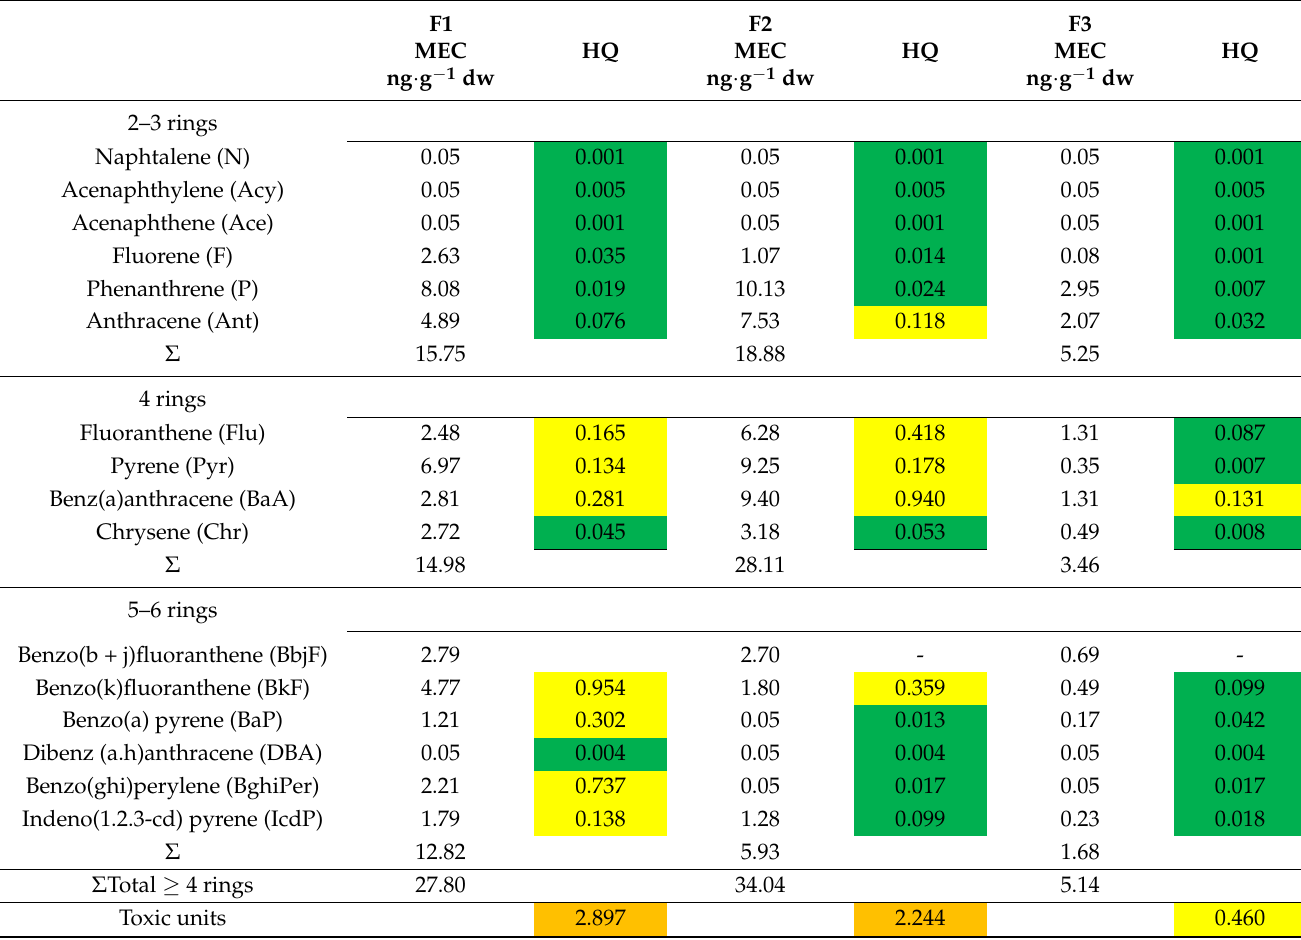
Table 3. Measured environmental concentrations (MEC) and Hazard Quotient (HQ) for the analyzed PAHs in sediments in F1, F2, and F3. Compound name abbreviations are in brackets.